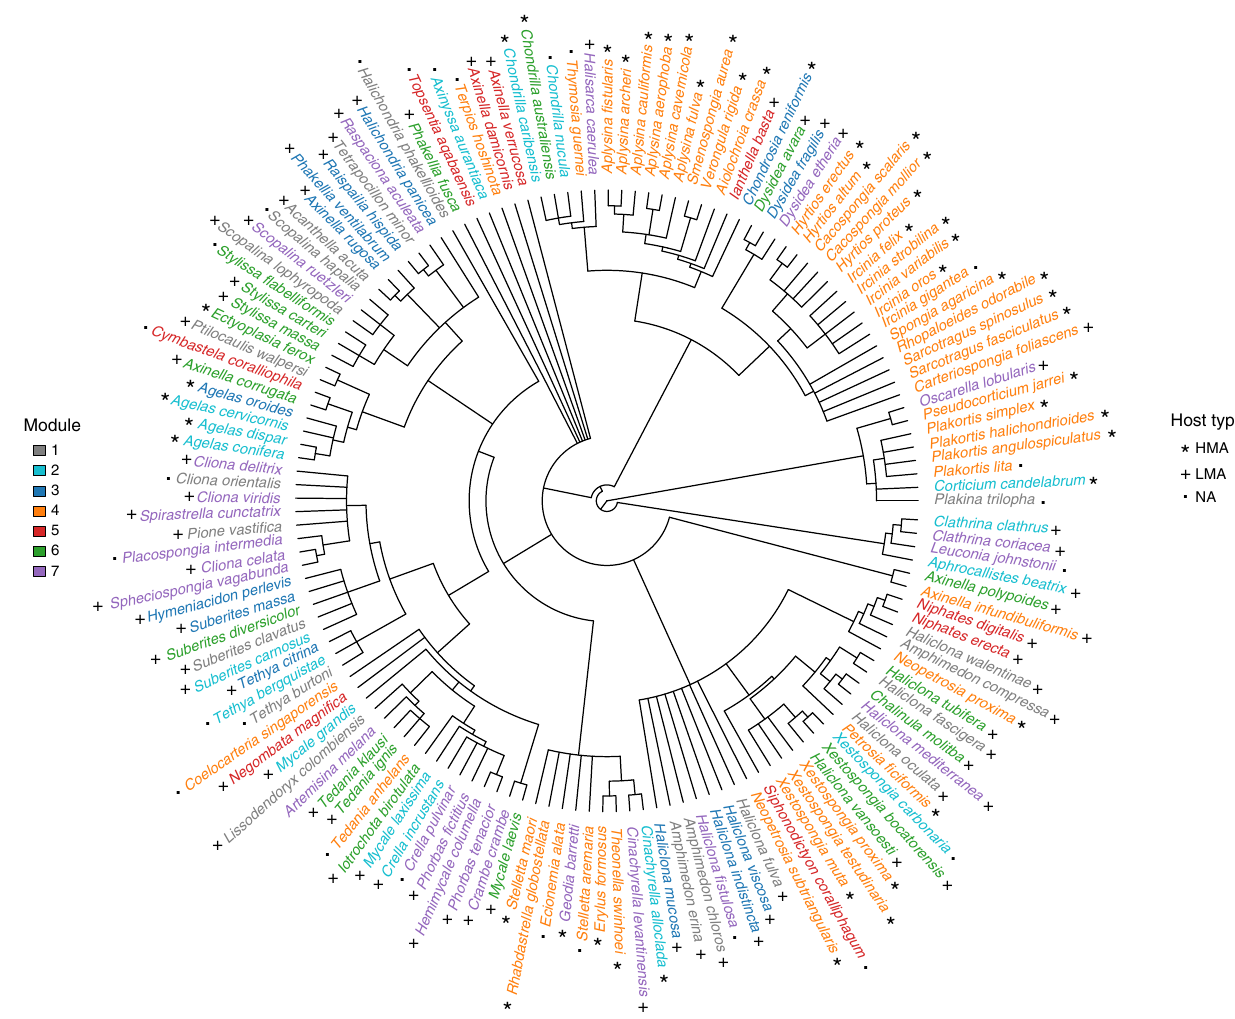
Fig. 2 Sponge phylogeny is associated with core network modularity. Sponge species belonging to the same module identi fi ed over the sponge core – microbiome network display the same colour. Stars, crosses and fi lled squares refer to sponge type according to whether they are high- or low- microbial abundance species (HMA and LMA respectively). NA = no information for host type is available. Only 144 out of the 156 host species considered in this study are shown because 10 of the original host species were not resolved to the species level and the sponge species Ircinia fasciculata and Strongylacidon conulosa did not have matches in the Open Tree of Life from which this tree was extracted (see Methods). For a complete list of